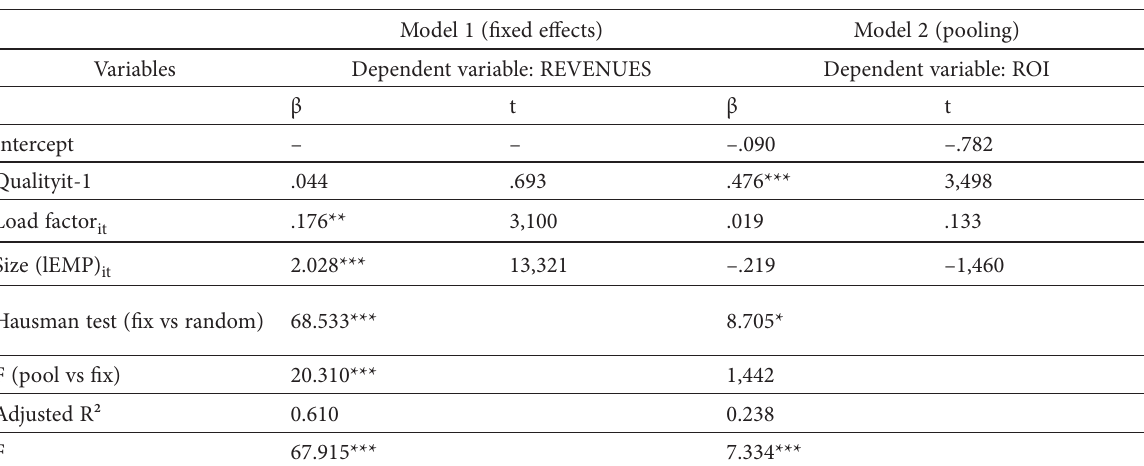
Table 4. Estimation models